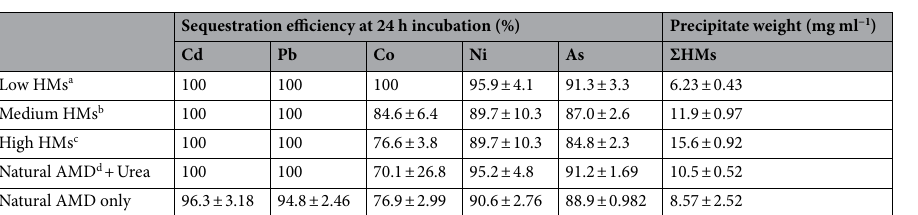
Table 3. Growth associated sequestration and precipitation of heavy metals/metalloid cocktail and AMD from Onyeama coal mine. Values are mean (± SEM) of triplicate experiments. a Low HMs broth comprised (per (per liter) Cd, 139.3 mg; Pb, 593.3 mg; Co, 81.1 mg; Ni, 80.7 mg; and As, 307.6 mg. d At the start of experiment, Natural AMD from coal mine used in this study contained (per liter) Cd, 95.0 ± 5.12 mg; Pb, 326 ± 26.8 mg; Co, 27.3 ± 9.25 mg; Ni, 28.8 ± 13.4 mg; and As, 56.7 ± 14.7